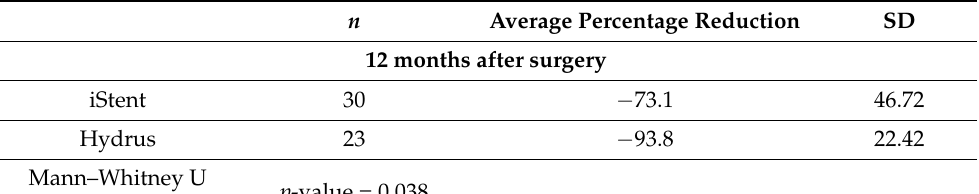
Table 3. Percentage reduction in the number of antiglaucoma medications before surgery, and 12 and 24 months after surgery.